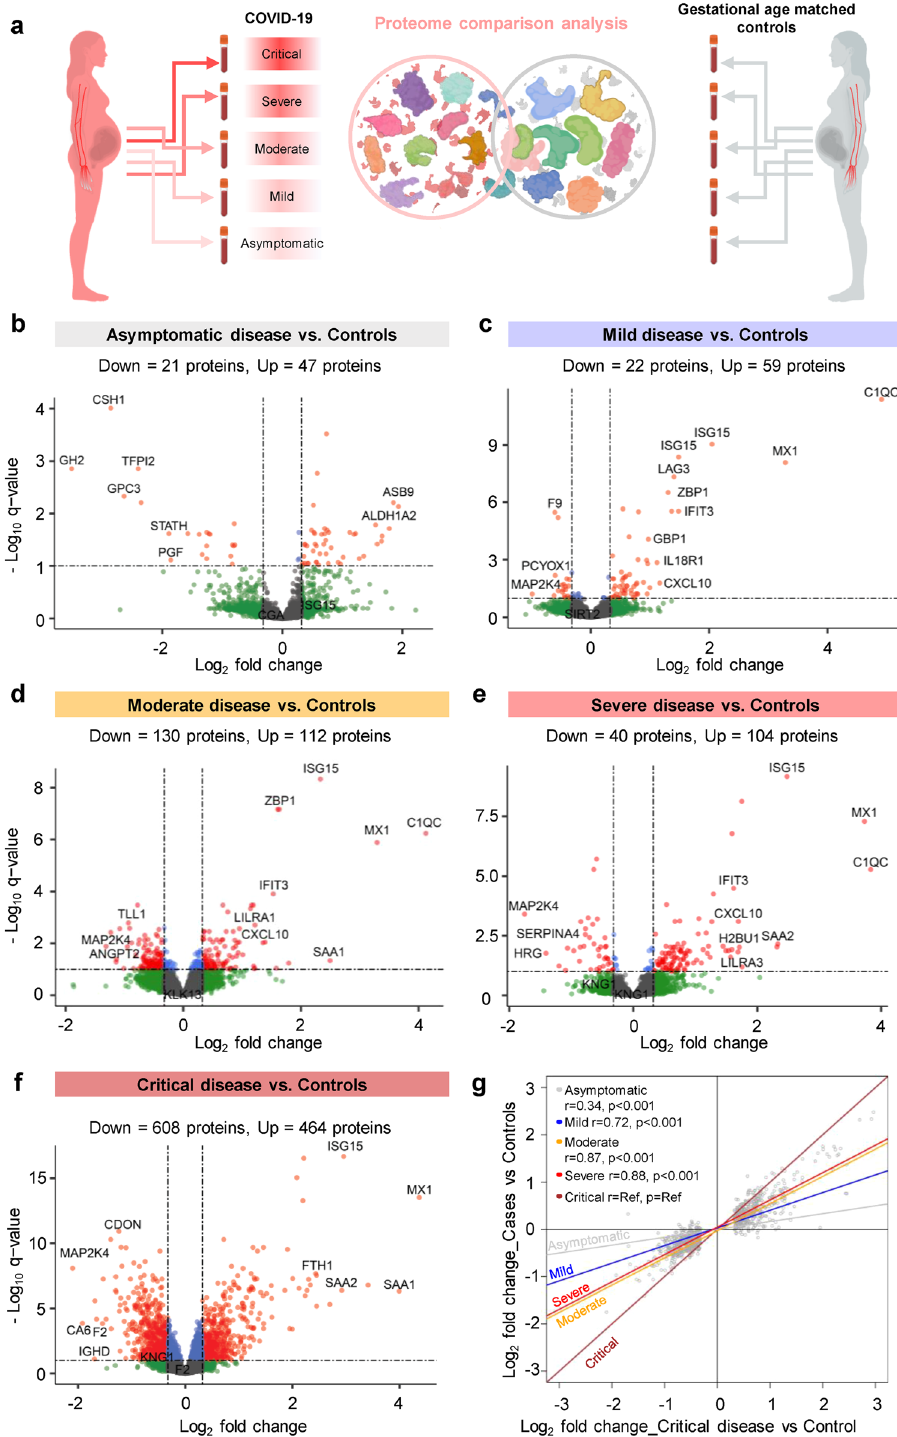
Fig. 2 The plasma proteome shows increasing perturbation with COVID-19 severity in pregnancy. a Graphical representation showing the comparison of plasma proteomes between each classi fi ed subset of pregnant COVID-19 cases and controls. b Volcano plot showing the proteins modulated in asymptomatic COVID-19 cases compared to controls. Red = proteins with q < 0.1 and fold change > 1.25, green = proteins with q ≥ 0.1 and fold change >1.25, gray = proteins with q ≥ 0.1 and fold change ≤ 1.25, blue = proteins with q < 0.1 and fold change ≤ 1.25. c Volcano plot showing the proteins modulated in mild COVID-19 cases compared to controls. d Volcano plot showing the proteins modulated in moderate COVID-19 cases compared to controls. e Volcano plot showing the proteins modulated in severe COVID-19 cases compared to controls. f Volcano plot showing the proteins modulated in critical COVID-19 cases compared to controls. g Comparison of the magnitude of proteomic changes among pregnant COVID-19 case subsets, using the comparison between critical cases vs. controls as the reference. Spearman ’ s correlation and p-value are provided for the asymptomatic vs. control, mild vs. control, moderate vs. control, and severe vs. control contrasts compared to the reference. The proteins included in this analysis (gray dots) are those 1,072 identi fi ed as differentially abundant in the comparison between pregnant critically ill cases vs.